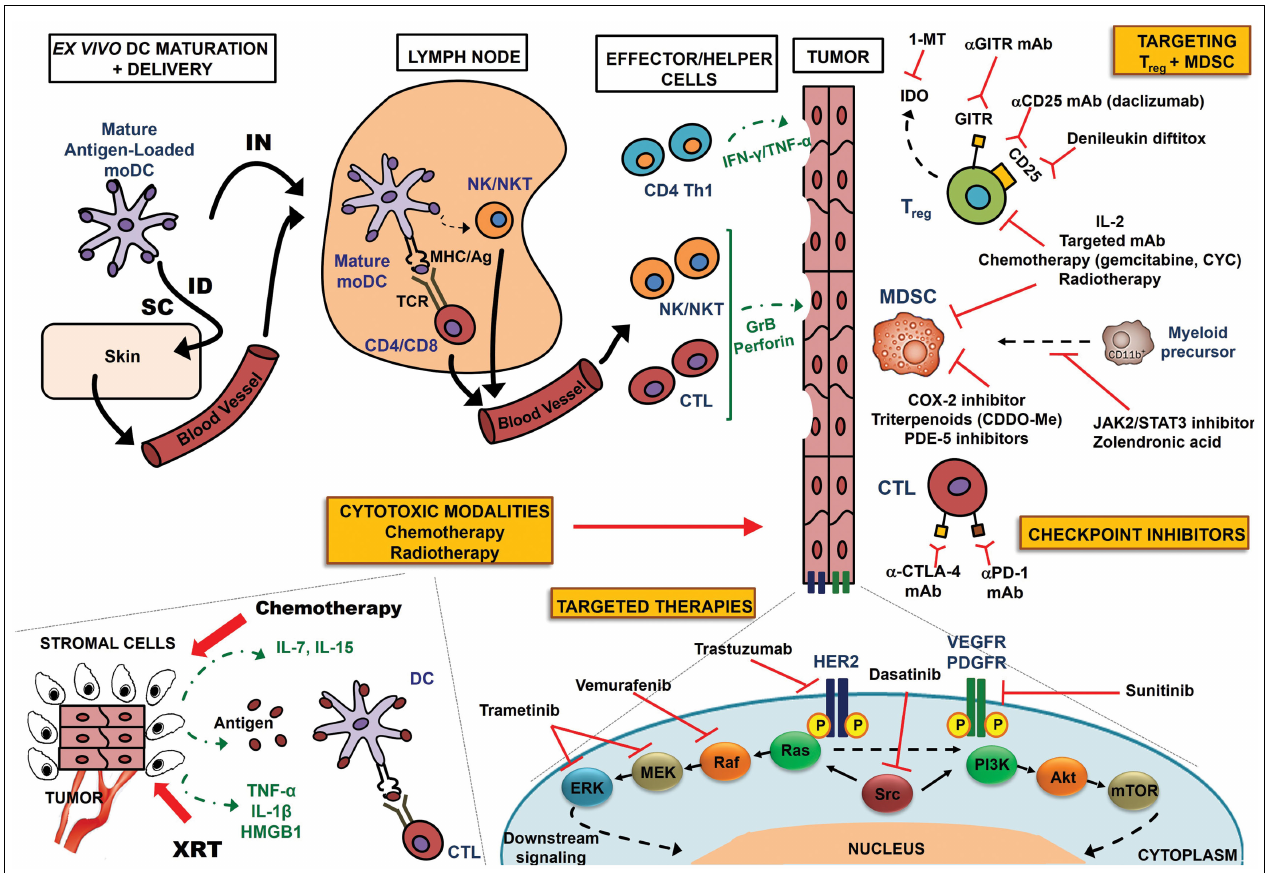
FIGURE 1 | Multimodality approach to optimize DC-based immunotherapy . Antigen-specific T-cell responses can be induced by traditional ex vivo -manipulated DCs or DC receptor targeting in vivo (not shown in this schematic). In ex vivo manipulation, monocyte precursors are sequentially matured with proinflammatory cytokines, loaded with antigen, and injected either IN or ID/SC. Lymph nodes serve as sites of T-cell co-stimulation, whereby DCs present antigen to T-cells in the context of MHC Class I/II molecules, triggering antigen-specific CD4 + Th1 cells